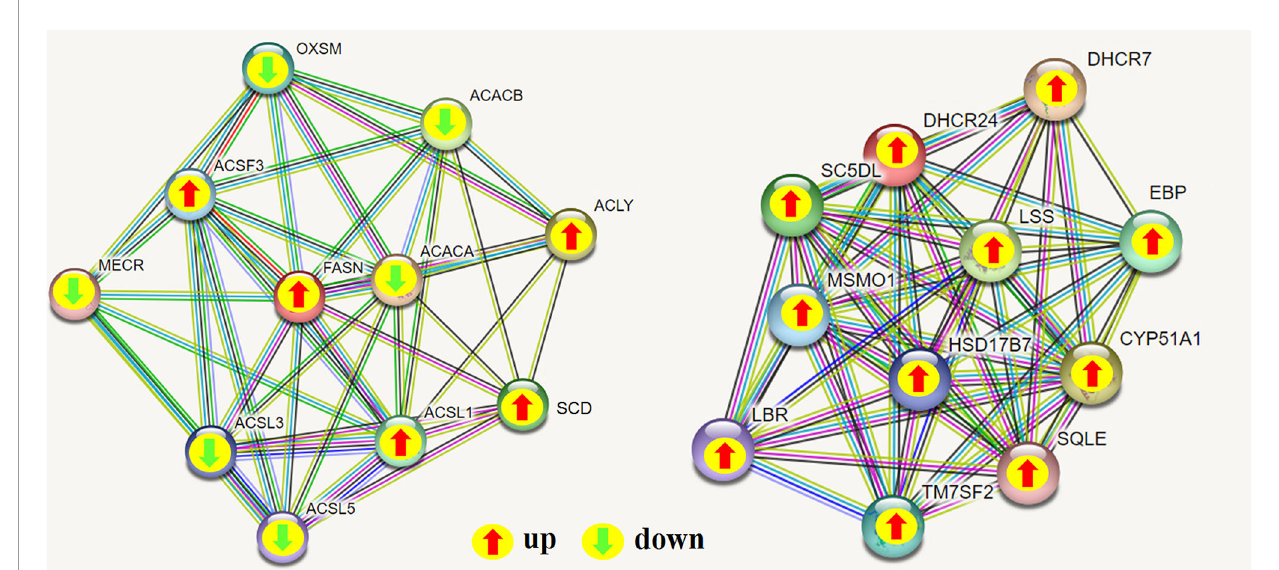
FIGURE 8 | Protein-protein interaction (PPI) network analyses of DEPs involved in regulating lipid metabolism were performed using the STRING database while focusing on FASN and DHCR24. The green arrow represents down-regulated expression, and the red arrow represents up-regulated expression; green line: gene neighborhood; red line: gene fusion; blue line: gene co-occurrence; yellow line: text mining; black line: co-expression; light purple line: protein homology.